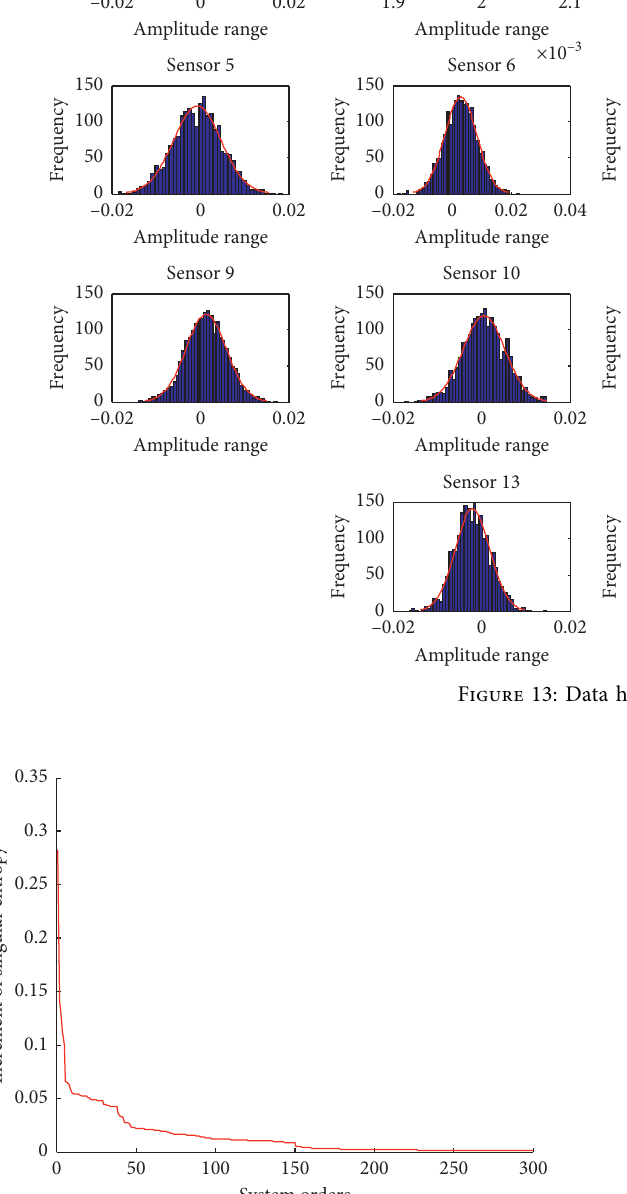
Figure 15: The slope trend of the change in singular